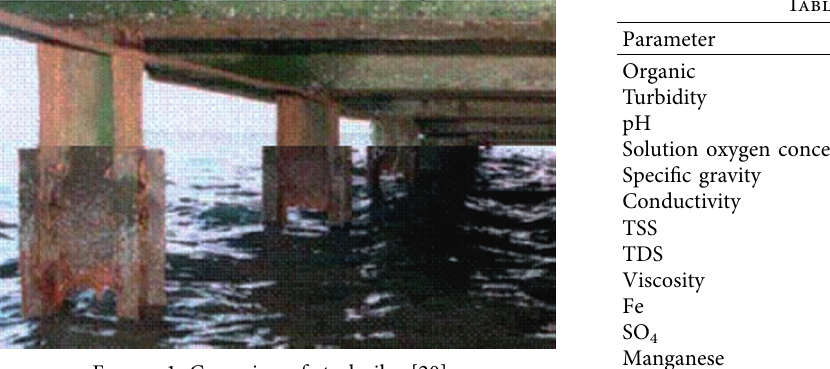
Figure 1: Corrosion of steel piles [20].